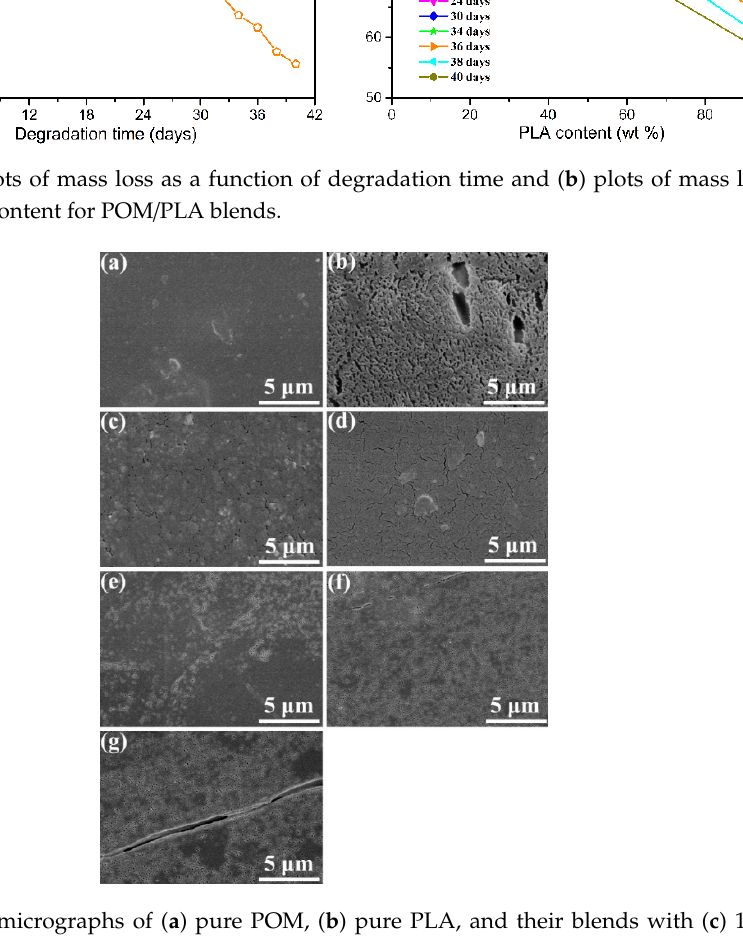
Figure 16. SEM micrographs of ( a ) pure POM, ( b ) pure PLA, and their blends with ( c ) 10 wt %, ( d ) 20 wt %, ( e ) 30 wt %, ( f ) 40 wt % and ( g ) 50 wt % PLA after enzymatic